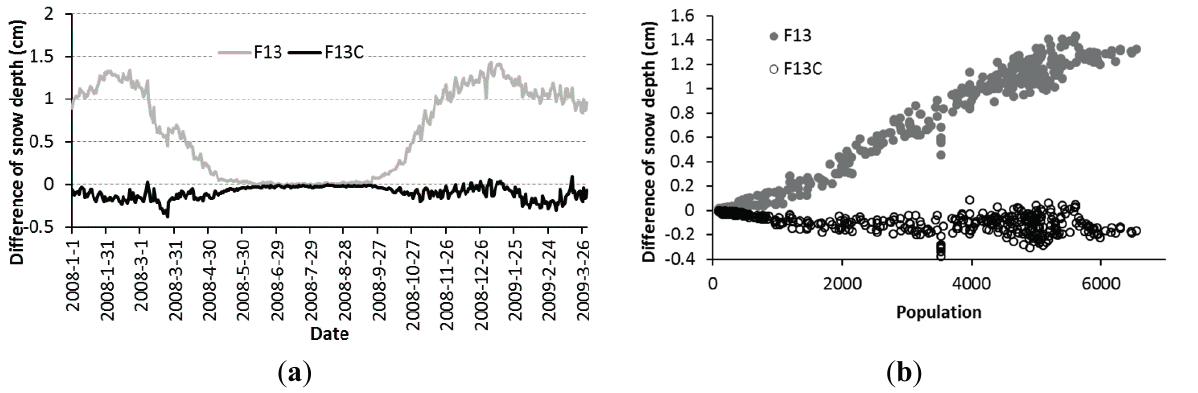
Figure 4. Average differences between snow depths from F13 and F17 and from F13C and F17 during the overlap period: ( a ) the variation in the mean difference between the snow depth from F13 and F17 over China for each day during the overlap period; and ( b ) relationship between the difference in the snow depth and snow-covered area (population). Table 3. Relative errors in the snow volume and population from F13 and F13C based on F17 for different snow depth (SD) ranges. F13 F13C Snow Volume Population Snow Volume Population SD > 0 66.18% 42.42% − 1.5% 1.65% 59.71%